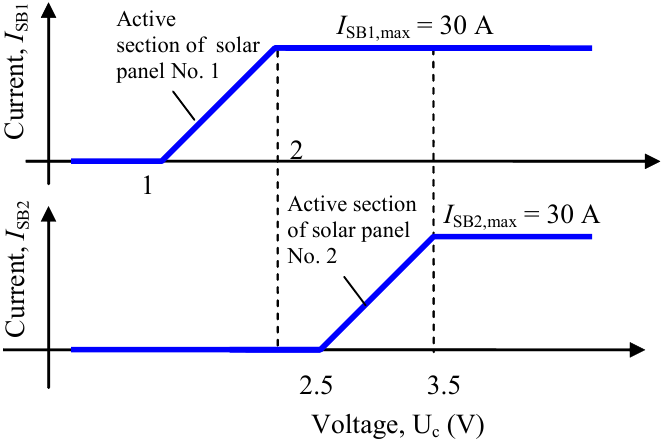
Figure 15. Mutual arrangement of regulation ranges for two solar panels.